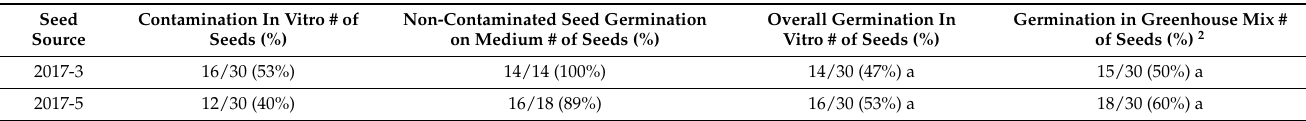
Table 9. Xerophyllum asphodeloides whole seed germination on medium in vitro or in greenhouse soil after treatment to remove double dormancy 1